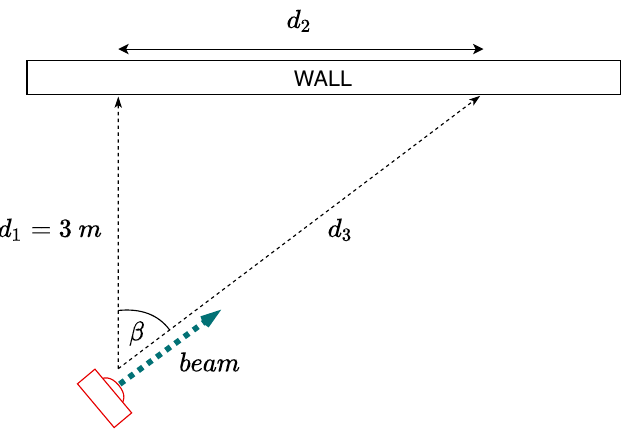
Figure 7. Top view representation of the ultrasonic sensor pointing the frontal wall with a certain incidence angle β .